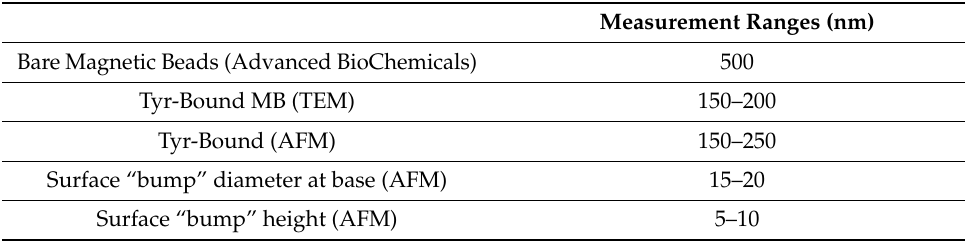
Table 2. AFM and TEM measurements on the makeup of the MB.